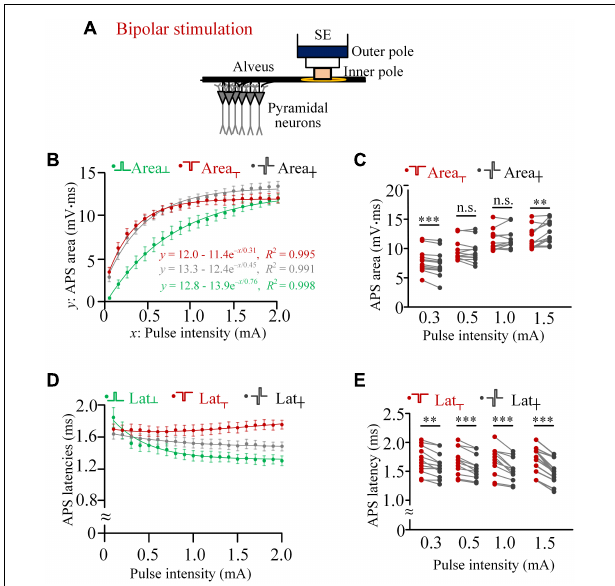
FIGURE 3 | Comparisons of activation efficiencies of anodic, cathodic, and biphasic pulses in bipolar stimulations in rat experiments. (A) Schematic diagram of the bipolar stimulation. (B) Changes of mean areas of antidromically evoked population spike (APS) evoked by the three types of pulses against the pulse intensity, together with exponential curve fitting. (C) Comparisons of mean areas of APS evoked by cathodic and biphasic pulses with pulse intensities of 0.3, 0.5, 1.0, and 1.5 mA ( ∗∗ p < 0.01, ∗∗∗ p < 0.001; n.s., not significant, paired t -test, n = 12). (D) Changes of mean latencies of APS evoked by the three types of pulses against the pulse intensity. (E) Comparisons of latencies of APS evoked by cathodic and biphasic pulses with pulse intensities of 0.3, 0.5, 1.0, and 1.5 mA ( ∗∗ p < 0.01, ∗∗∗ p < 0.001, paired t -test, n =